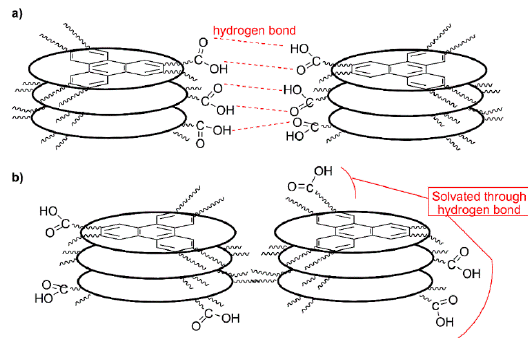
Figure 4. Possible self-assembly models for gels of triphenylene 1 – 3 in alcohols. ( a ) Hydrogen bond dimerization between the carboxylic functionalities, disfavored due to solvophobic effects; and ( b ) proposed mode of self-assembly with stabilization of the 1D columnar packing through solvation of the carboxylic groups located in the periphery pointing out to the polar environment